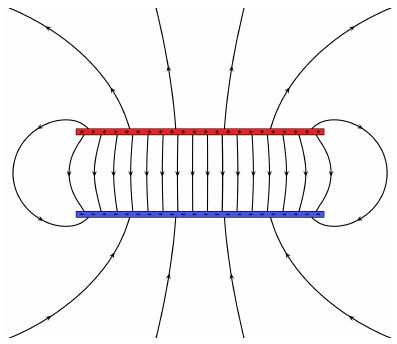
Figure 7. Eletric field (parallel plate capacitor).